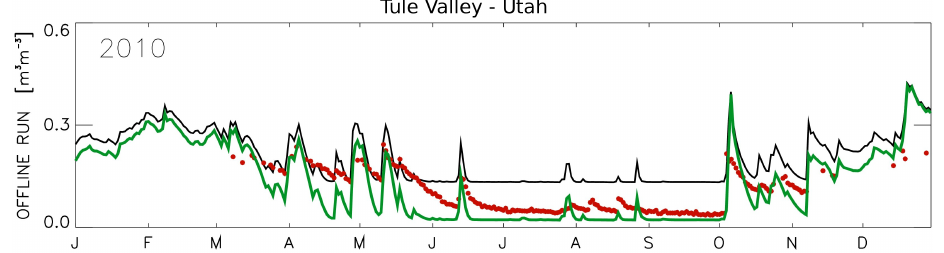
Fig. 4. Illustration of volumetric soil moisture time-series used in this study for one site in Utah (Tule Valley) for 2010. The black line is for BEVAP OLD (control experiment without the new bare ground evaporation formulation), green line is for BEVAP NEW (test with new formulation) and red dots are for in situ observations of soil moisture.